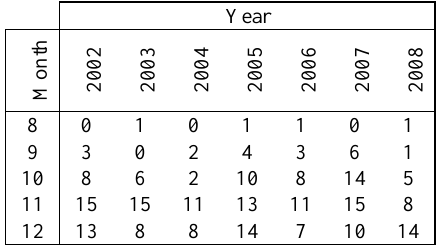
Table 1. The number of dates, including qualified satellite data for months 8 to 12 between 2002 and 2008.